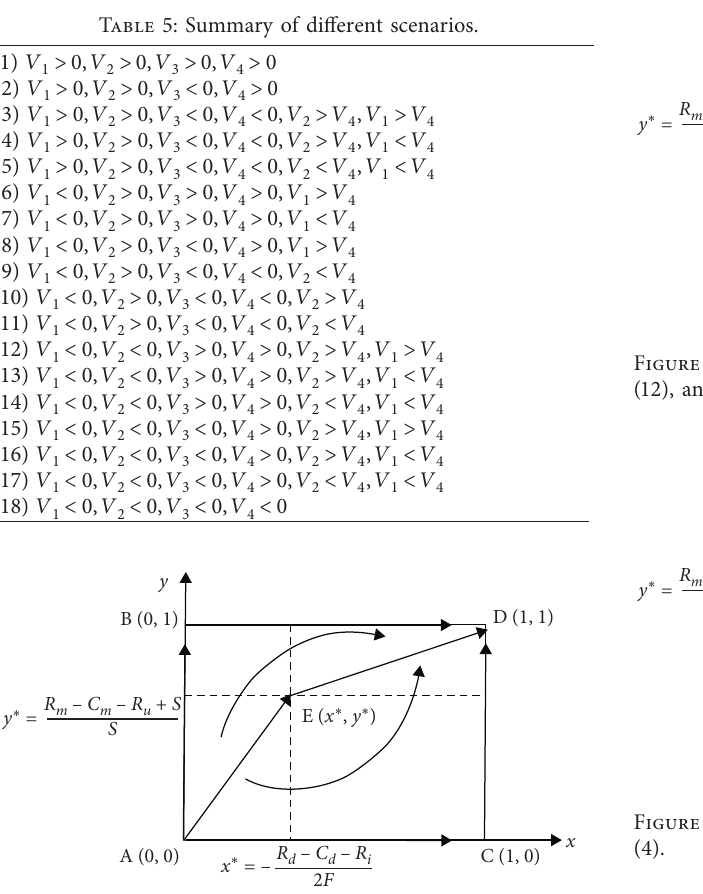
Figure 4: The replication dynamic phase map for scenarios (1) and (2).